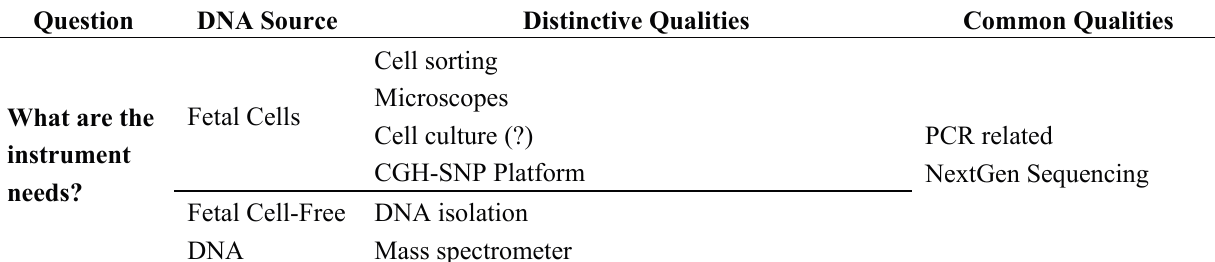
Table 2. Some distinctive and common qualities in the comparison of fetal cell and cell free DNA based prenatal